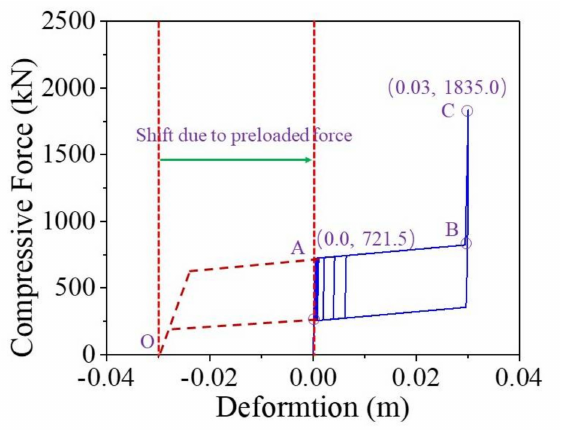
Figure 21. Compressive force vs. deformation of SMA washer